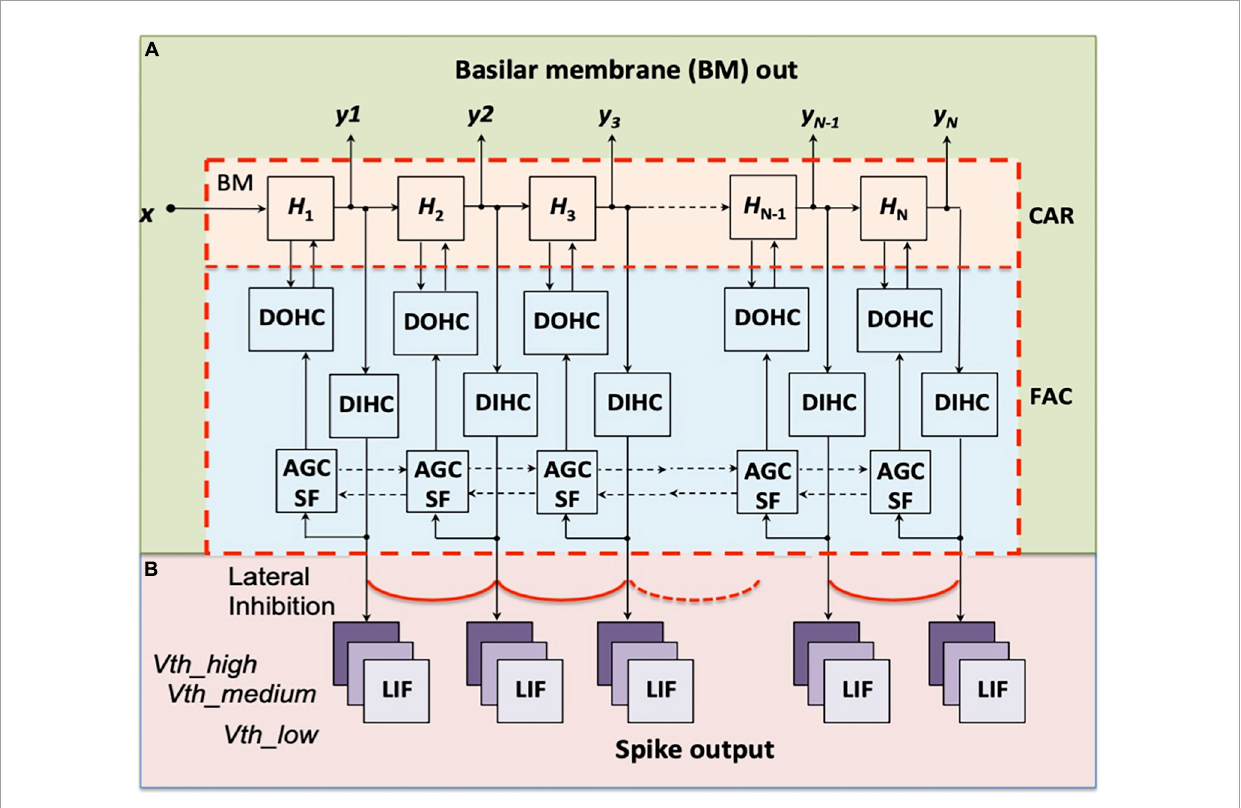
FIGURE1 Structure of the CAR-FAC model (A) and the LIF neurons preceded by lateral inhibition (B) . x is the input sound, H 1 to H N are the transfer functions of the CAR part, and y 1 to y N represent the CAR-FAC Basilar Membrane (BM) output. The characteristic frequencies (CFs) of the CAR resonators decrease from left to right. The DOHC, the DIHC and the AGC loop comprise the FAC part. Each DIHC is connected to nine LIF neurons with three thresholds, Vth_low , Vth_medium, and Vth_high , after a Lateral Inhibition function between neighboring